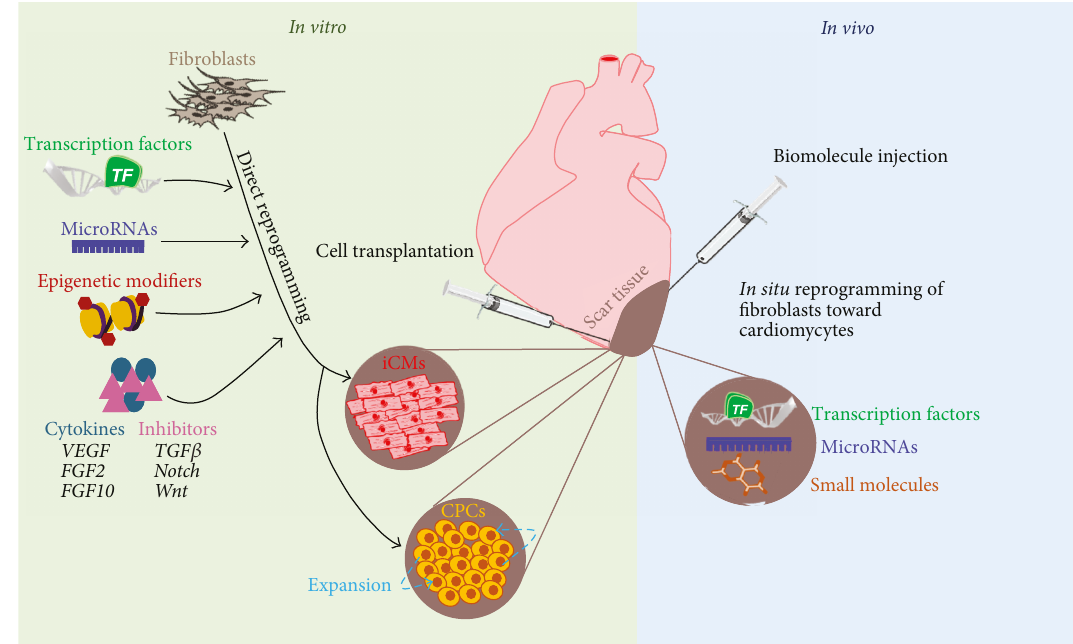
Figure 2: Schematic showing the current and future applications of direct cardiac